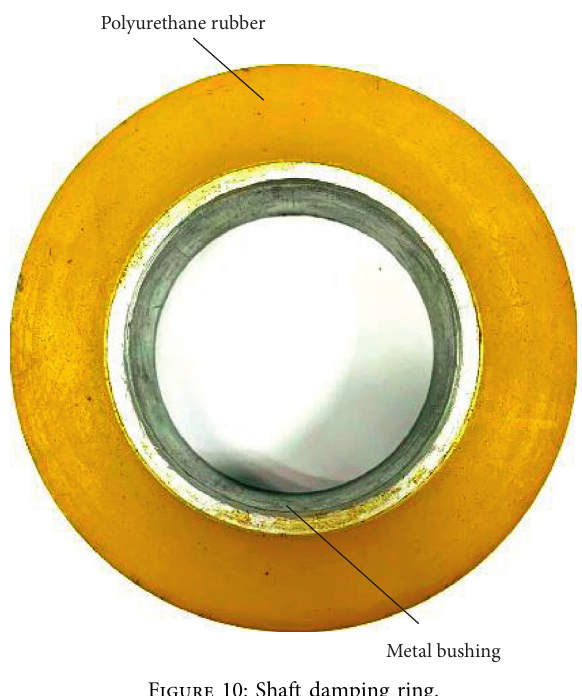
Figure 10: Shaft damping ring.